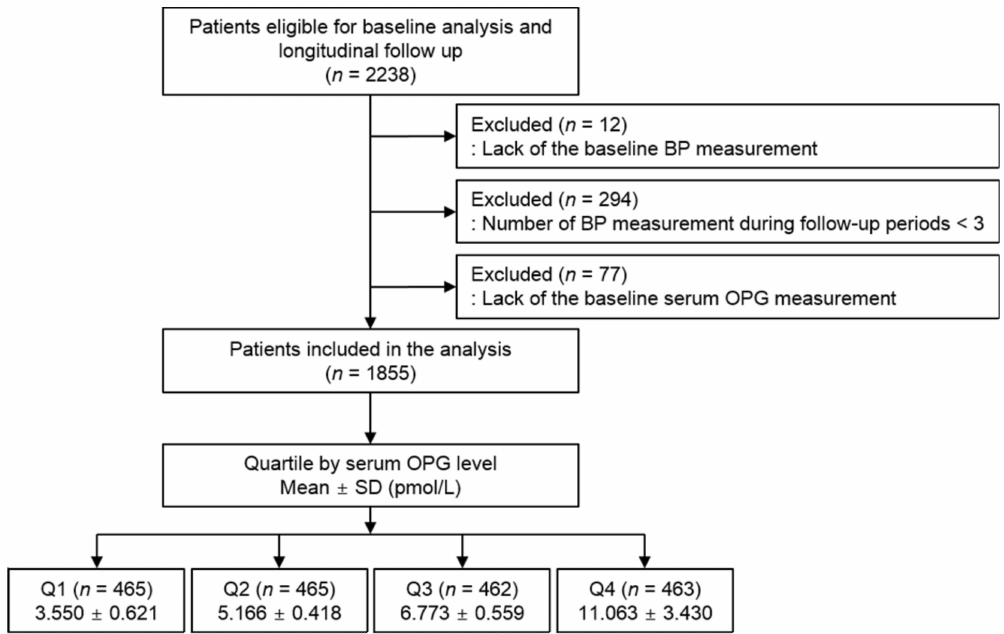
Figure 1. Flow diagram of the study participants. Abbreviations: ASV, average successive variability; BP, blood pressure; OPG, osteoprotegerin; Q1, 1st quartile; Q2, 2nd quartile; Q3, 3rd quartile; Q4, 4th quartile; SD, standard